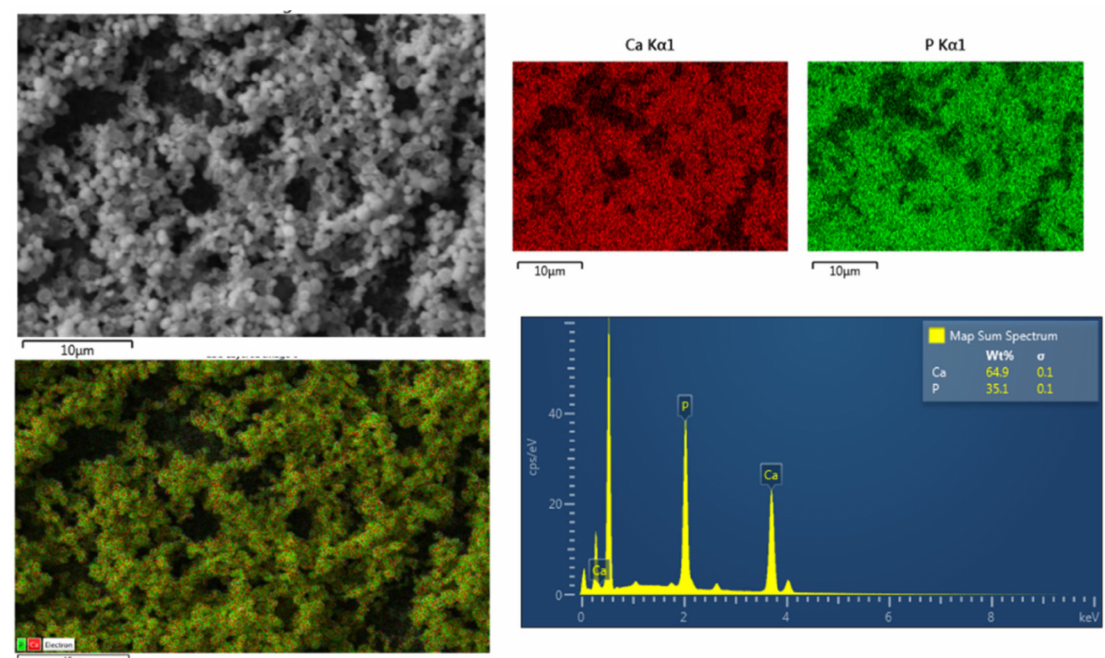
Figure 5. SEM image and EDX of K-GSGGG-HABP adhesive disc after